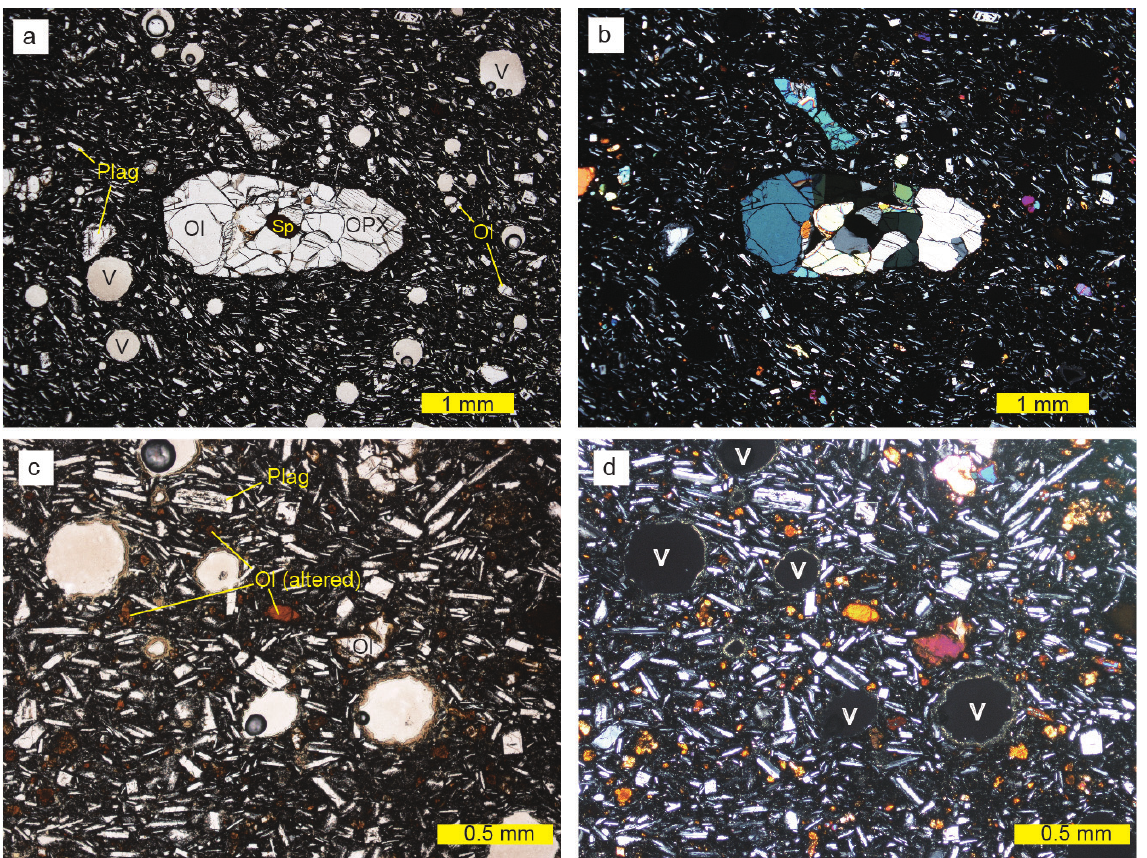
Figure 2. Photomicrographs of the studied Seifu Seamount basalt sample. (a) A peridotite xenolith in plane-polarized light. (b) Cross- polarized light image of (a) . (c) Typical texture of the studied Seifu Seamount basalt in plane-polarized light. (d) Cross-polarized light image of (c) . Ol: olivine, Plag: plagioclase, Sp: spinel, and V: